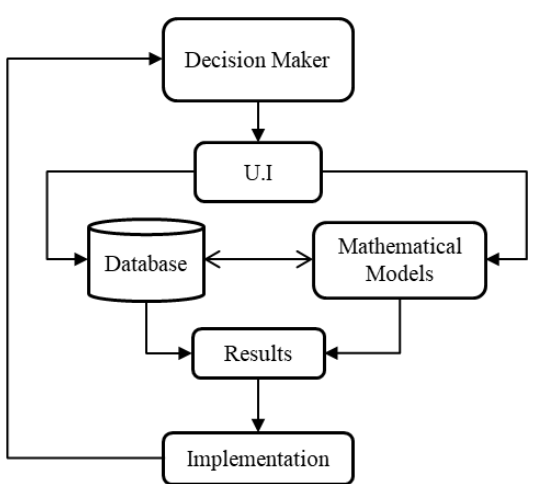
Figure 3. Decision Support System architecture of the IDF_CC tool and illustration of its support of the decision-making process.